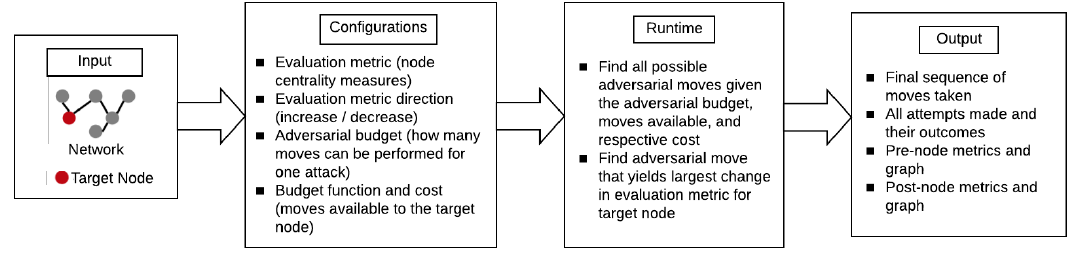
Figure 3. Adversarial network experimentation tool